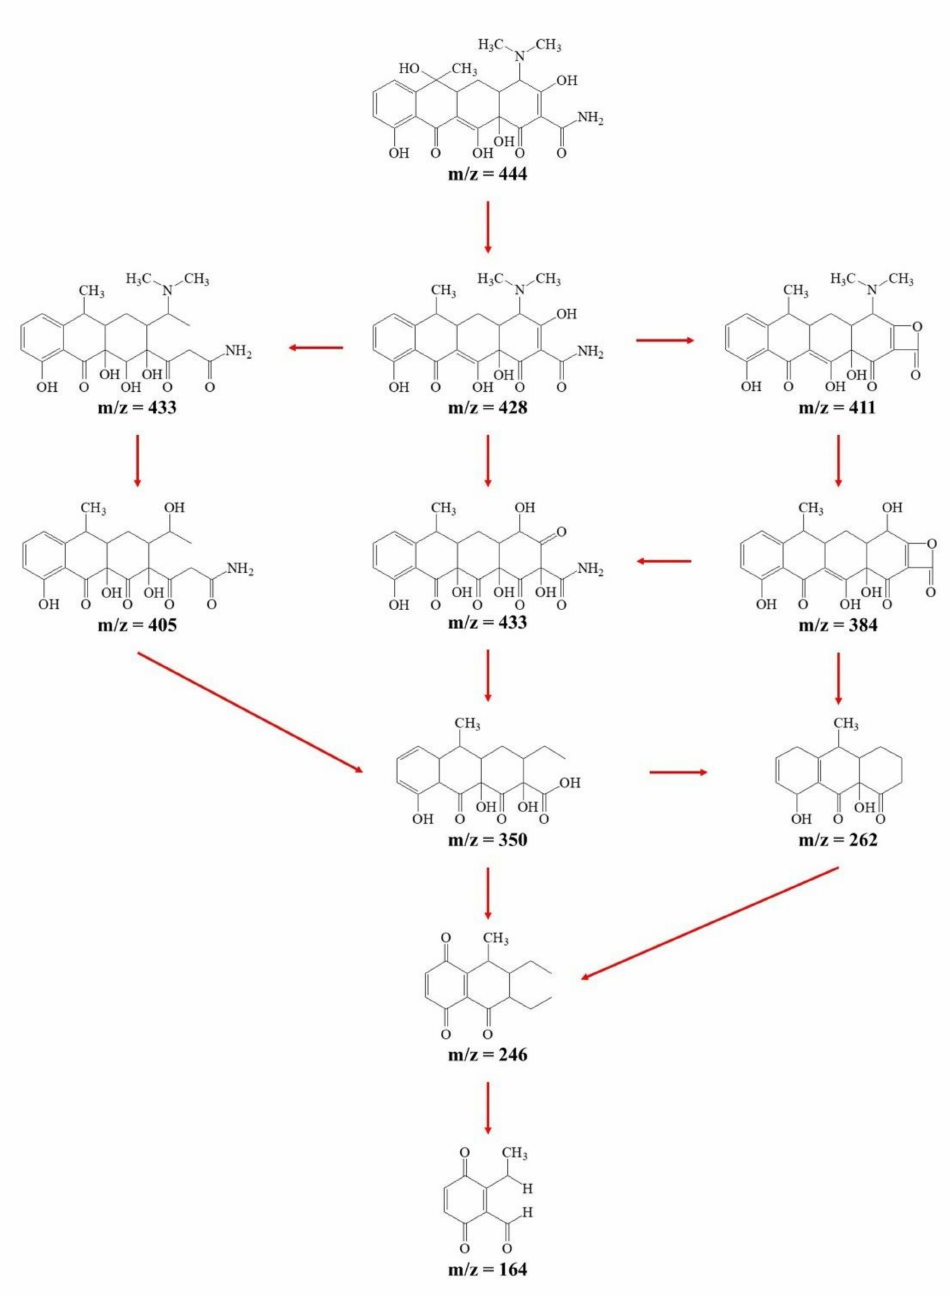
Figure 8. Proposed pathways of TC degradation by Ti/Ta 2 O 5 -IrO 2